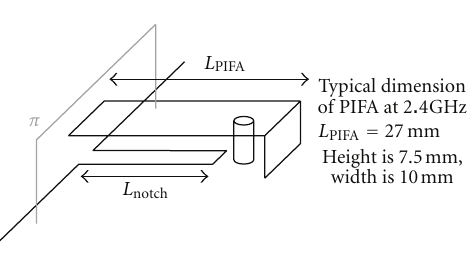
Figure 1: Close combination of PIFA and notch with complete overlap.